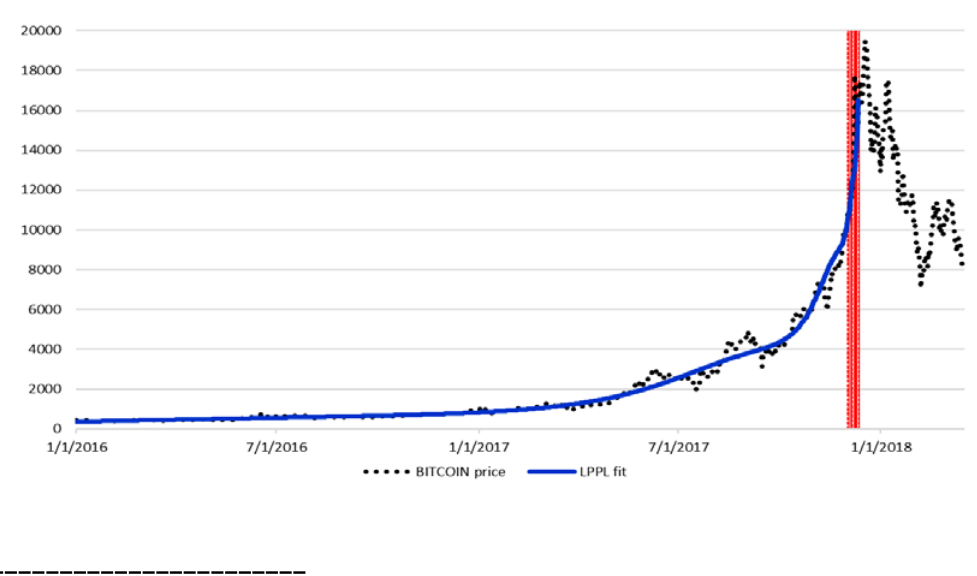
Figure 10: LPPL fit for BTC (model with the minimum